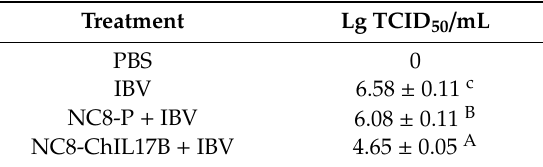
Table 2. The infectious bronchitis virus (IBV) proliferative titers in the HD11 cells under di ff erent treatments.